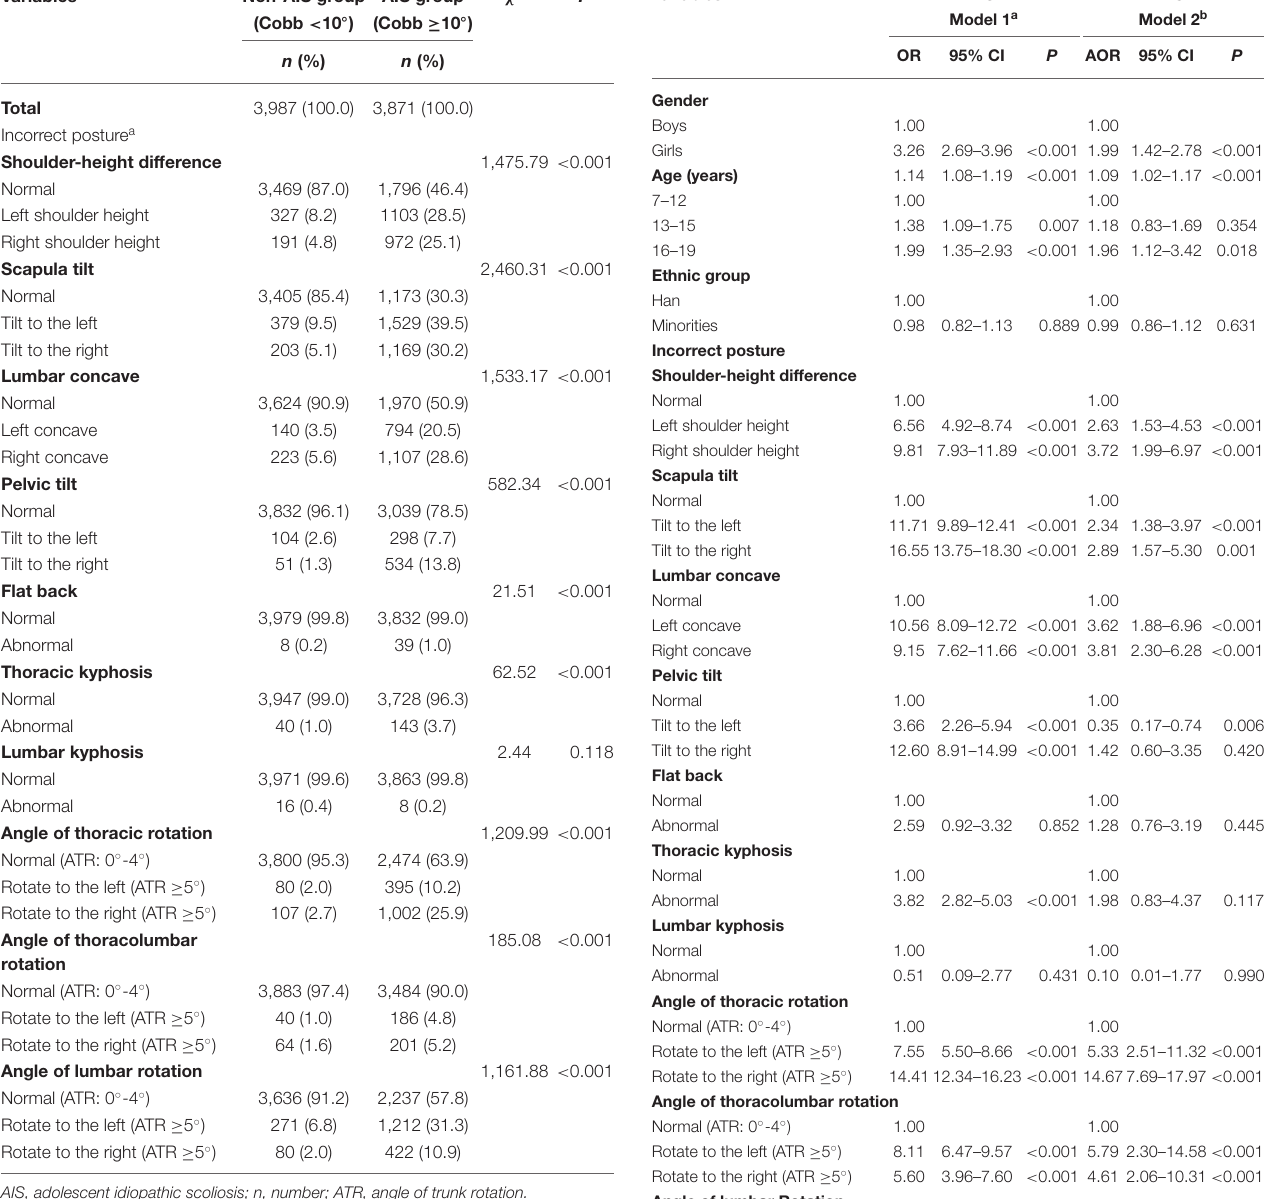
TABLE 2 | Prevalence of incorrect posture among Chinese adolescents stratified by the occurrence of AIS ( N = 7,858).